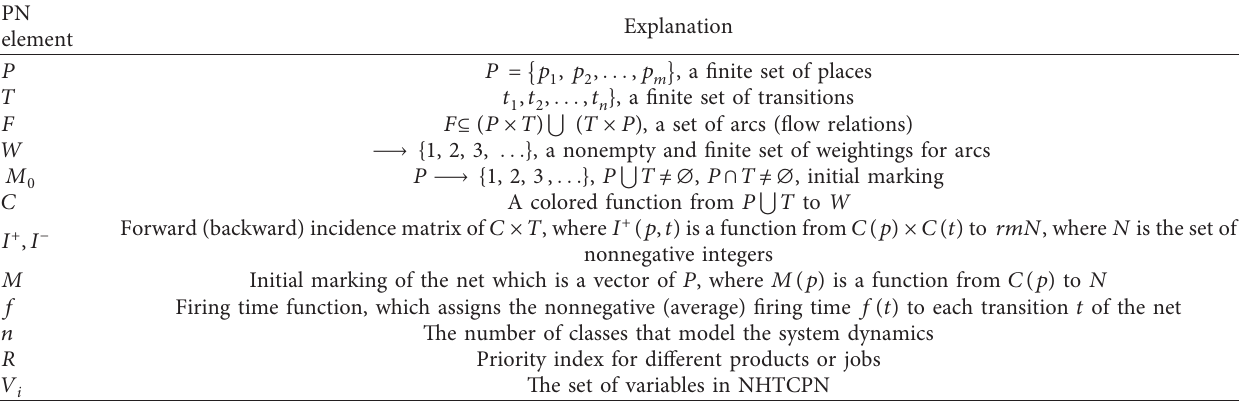
Table 1: PN element